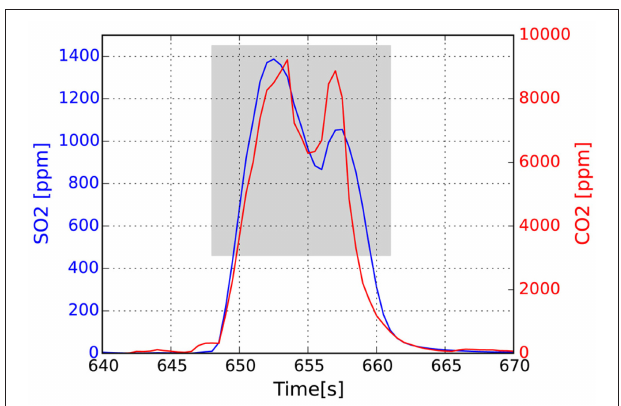
FIGURE 12 | Gas VMRs of the measurement inside the Fumarole Zero plume over time with backgrounds subtracted. From the data in the grey shaded area a CO 2 /SO 2 ratio of 6.8 was